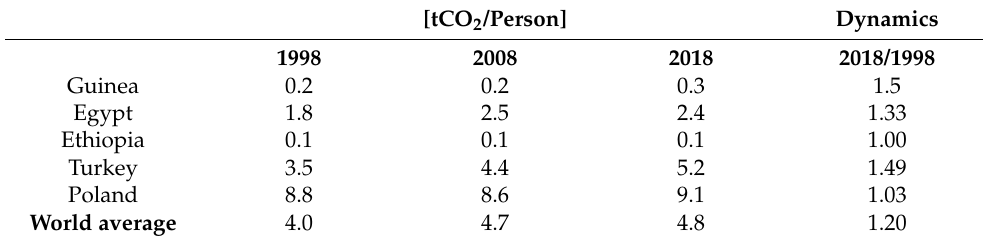
Table 4. Amount of CO 2 Emission and Dynamic of